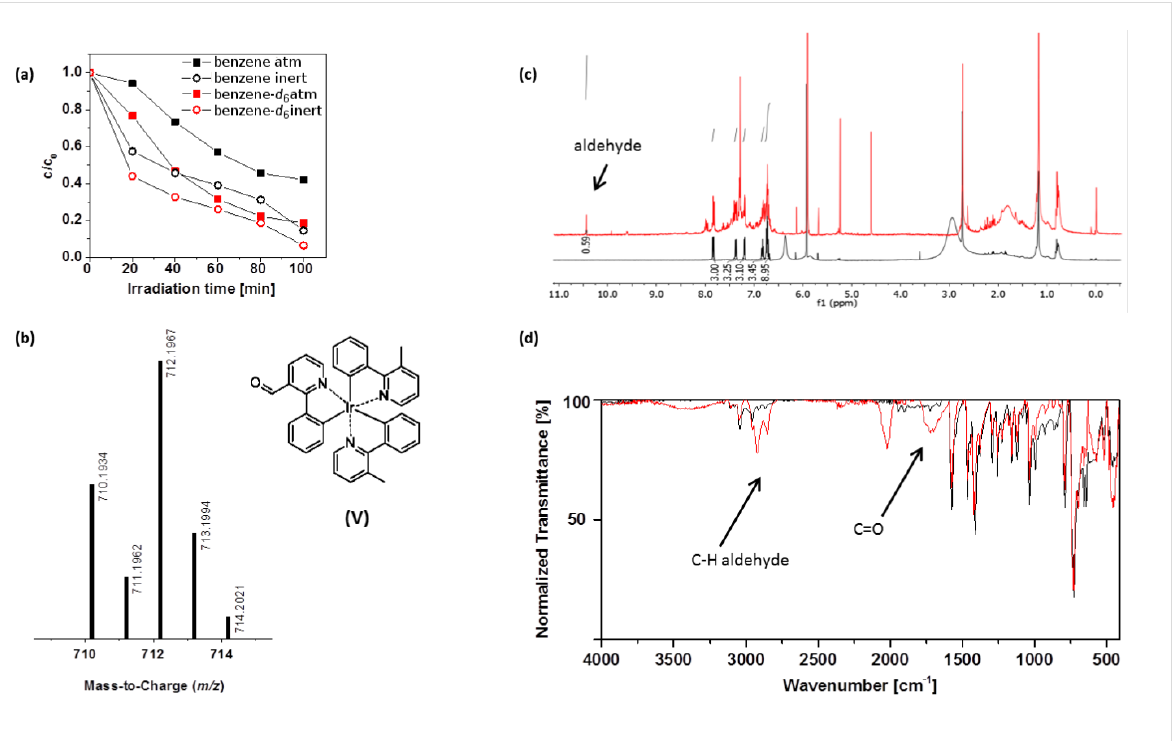
Figure 8: (a) Degradation curves of Ir(Me-ppy) 3 in benzene and benzene- d 6 under ambient and inert conditions. (b) Mass spectrum of the main degradation product with its assigned structure. The aldehyde functionality can be visualized by NMR (c) and IR (d) spectroscopy (black: non-irradi- ated sample, red: irradiated